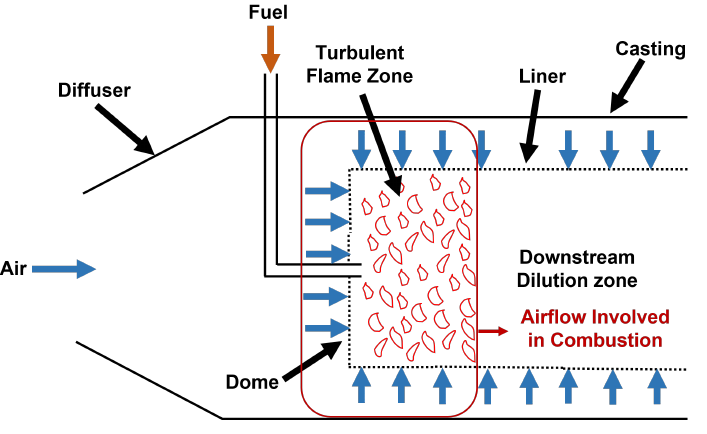
Figure 5. The physical model of FV LBO expression